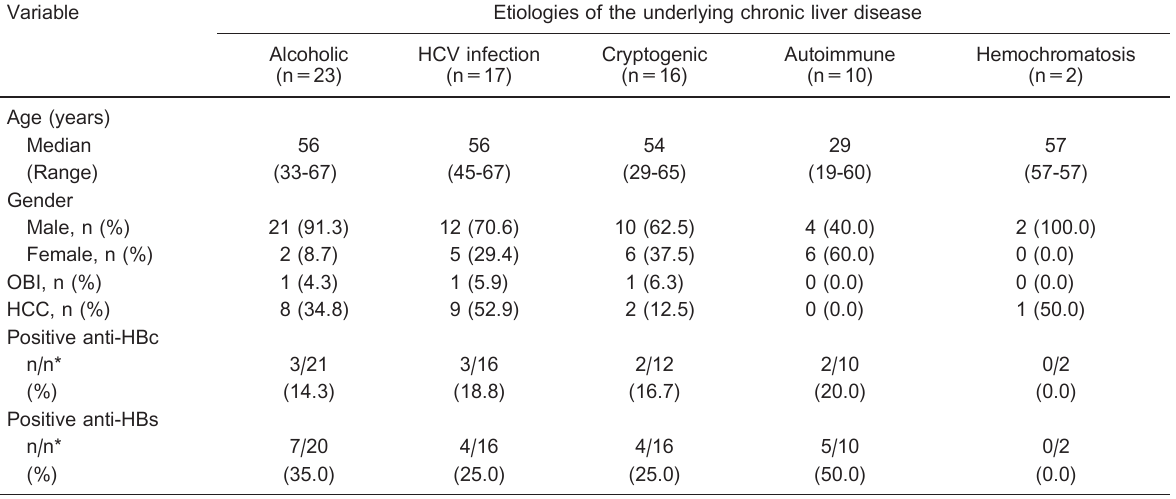
Table 1. Distribution of demographic and clinical data, and markers of previous HBV infection according to the etiologies of the underlying chronic liver disease.